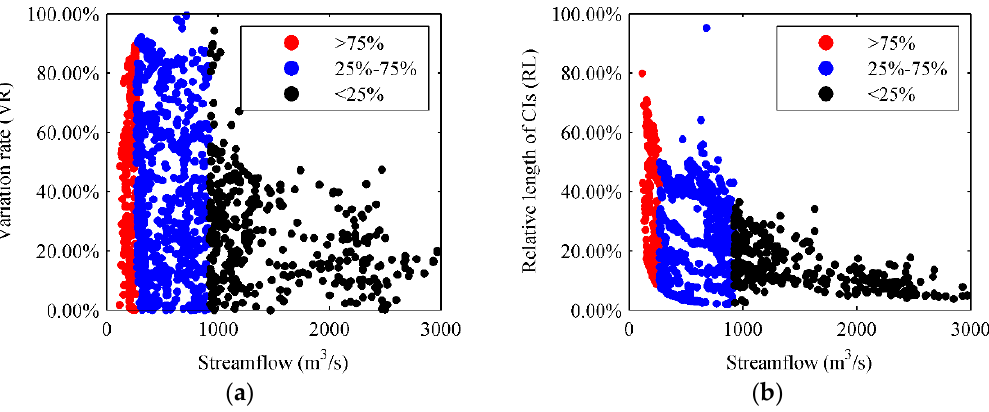
Figure 4. ( a ) The influence of parameter uncertainty on variable rates under different levels; ( b ) the influence of parameter uncertainty on the relative length of the confidence interval under different levels.